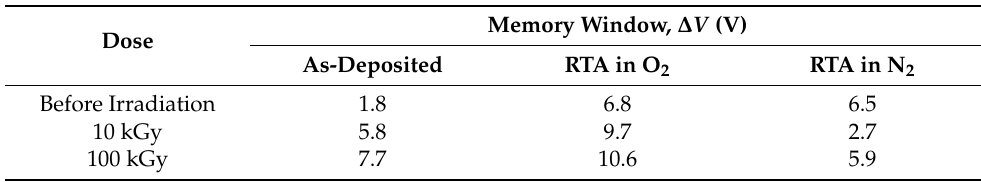
Table 1. Comparison of the memory windows ∆ V of the investigated stacks as measured at V p = ± 15 V before and after irradiation.